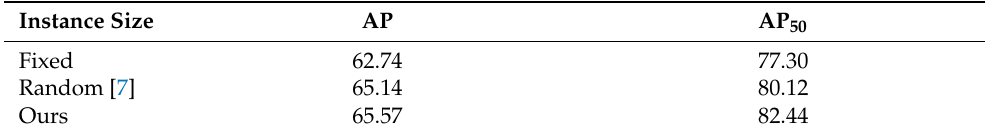
Table 2. Analysis experiment on instance size.